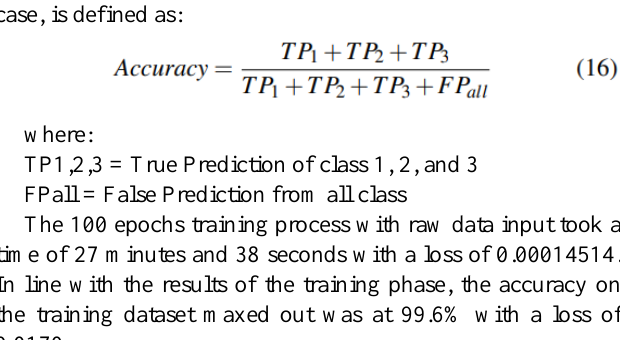
Fig. 8. Loss across the different inputs